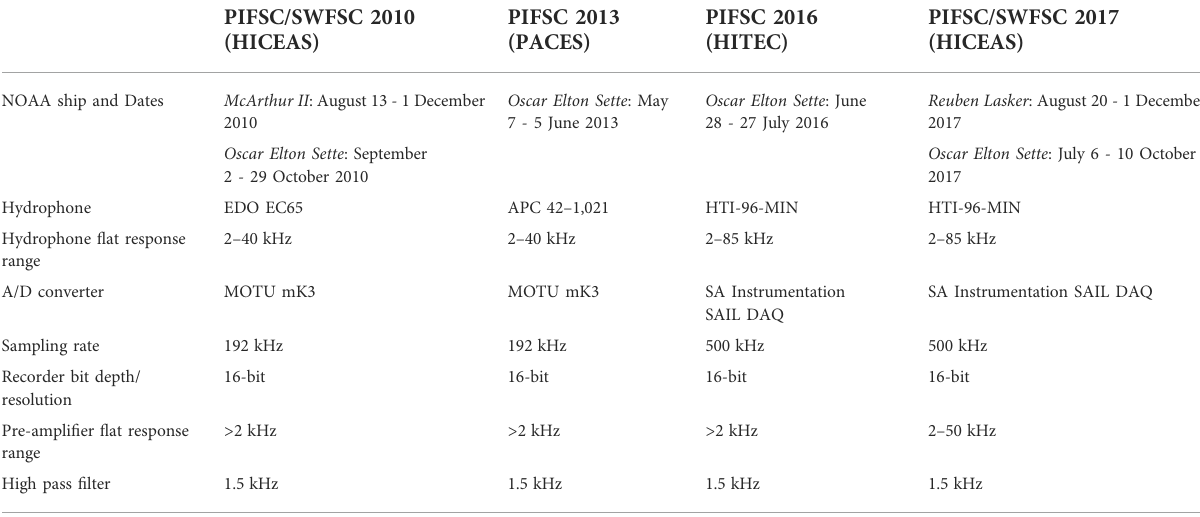
TABLE 1 Details and speci fi cations of the towed line arrays and equipment used for collecting passive acoustic monitoring data during four line- transect surveys conducted in the Hawaiian